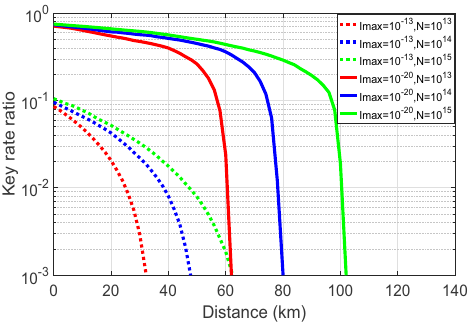
/ℓ ′ I ) between the secret key rates in logarithmic scale with and without max > 0 max = 0